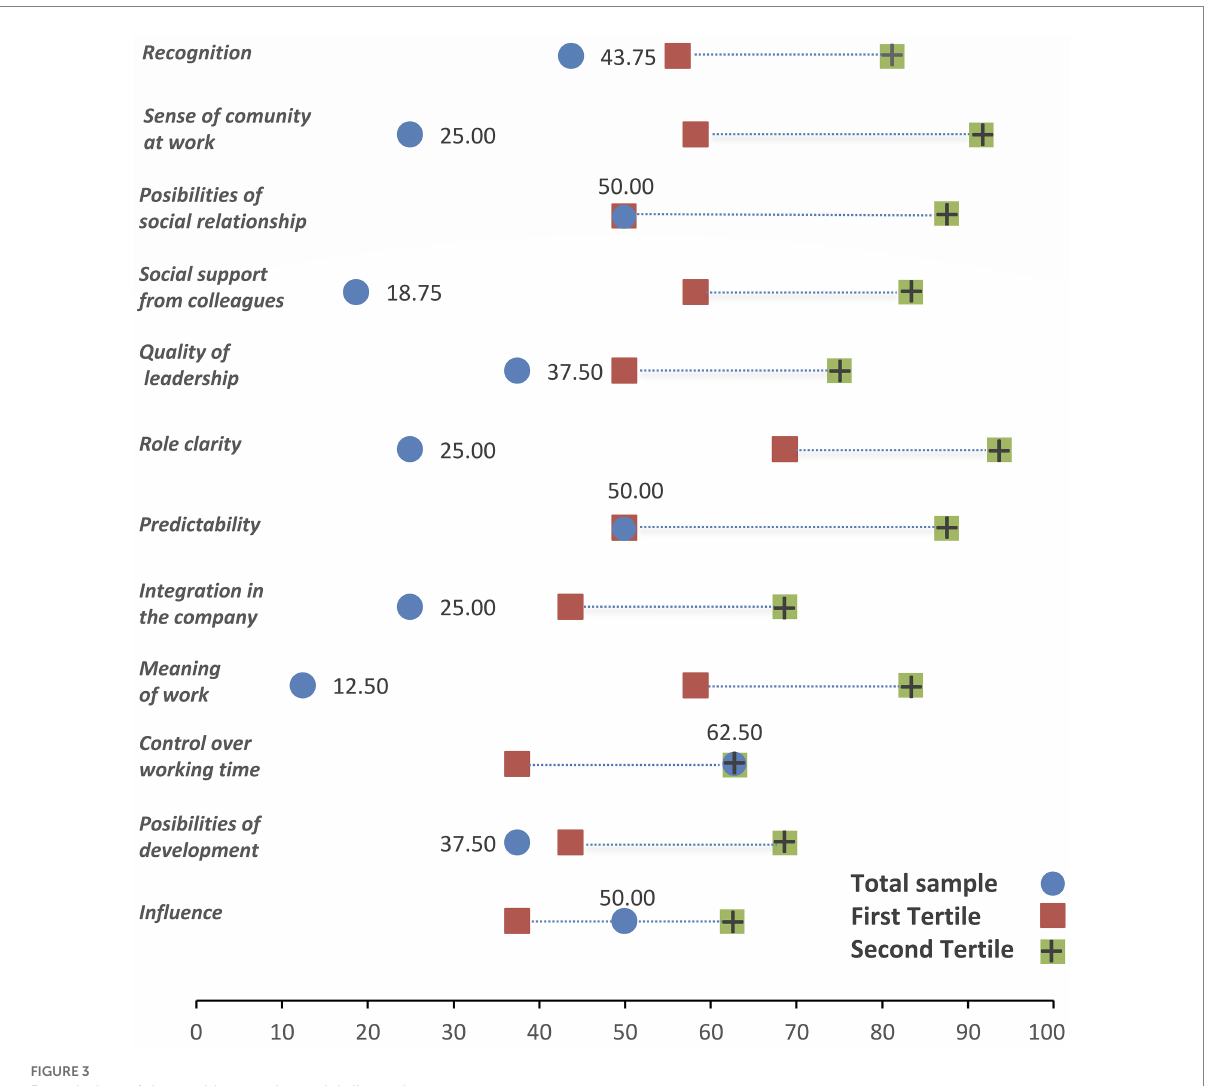
FIGURE 3 Description of the positive psychosocial